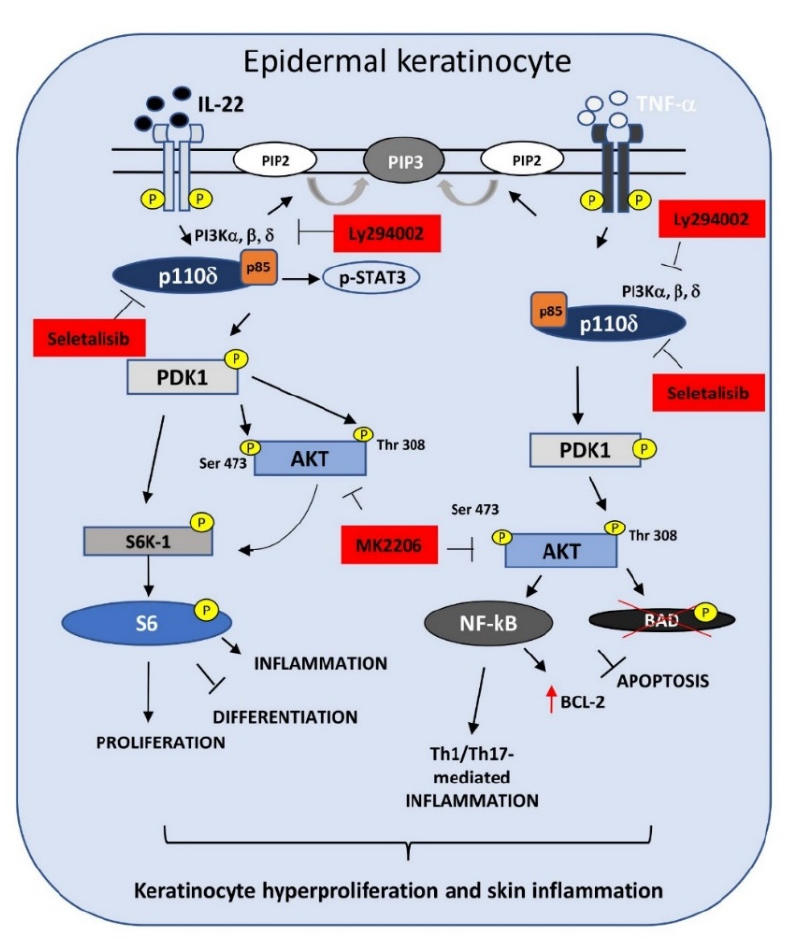
Figure 8. A graphical model on the role of PI3K δ in regulating the molecular mechanisms and biological processes induced by TNF ‐α and IL ‐ 22 in human keratinocytes. PI3K δ pathway can be activated upon stimulation of receptor tyrosine ki ‐ nases (RTK) by TNF ‐α or IL ‐ 22 cytokines, leading to PI3K δ activation which in turn phosphorylates PIP2 to PIP3. We assume that PI3K δ activation by IL ‐ 22 leads to phosphorylation of PDK1, which results in activation of S6 ribosomal pro ‐